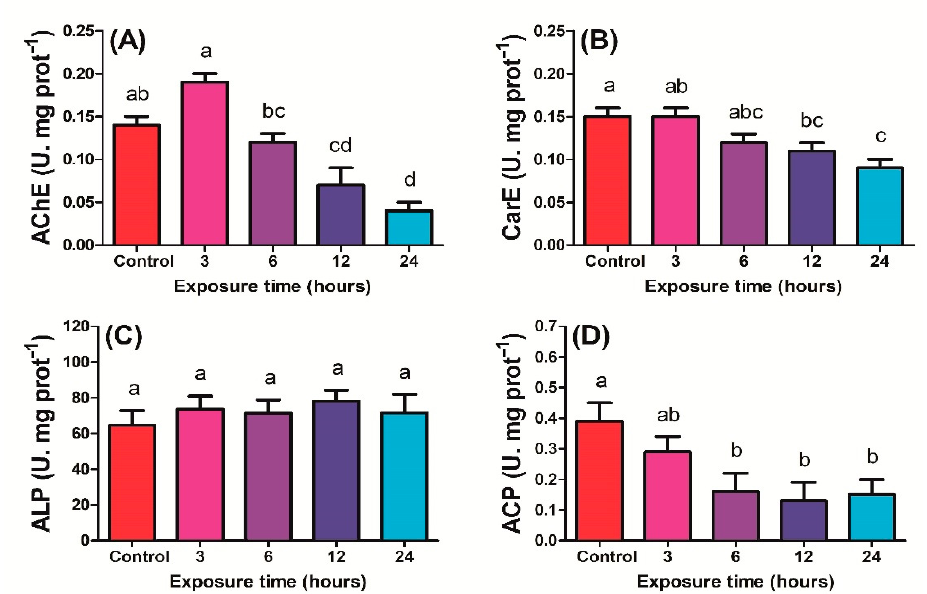
Figure 2. Activities of detoxification enzymes ( A ) AChE, ( B ) CarE, ( C ) ALP, and ( D ) ACP of Plutella xylostella larvae exposed to UV − light for control (0 h), 3, 6, 12, and 24 h. The bars indicate the mean value of four replications, and standard error bars indicate the standard deviation of the mean. Lowercase letters indicate a significant difference among the treatments at P < 0.05, and similar letters have no significant difference among treatments.